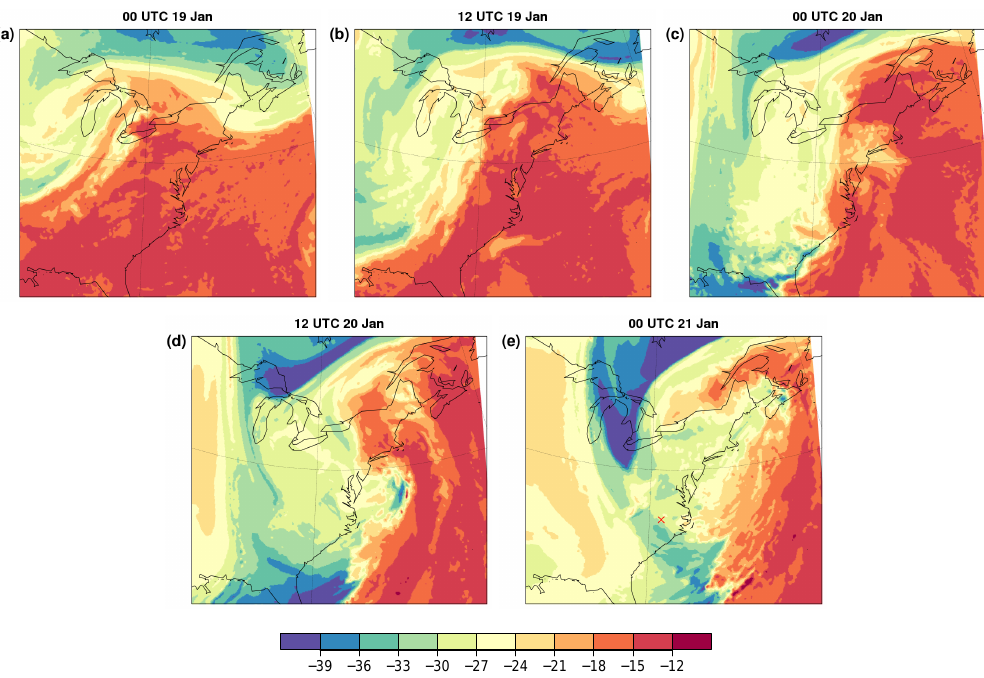
Fig. 9. δ 18 O in water vapour (in ‰) on 850hPa at (a) 00:00UTC 19 January, (b) 12:00UTC 19 January, (c) 00:00UTC 20 January, (d) 12:00UTC 20 January and (e) 00:00UTC 21 January from the COSMO iso reference simulation. The red cross in panel (e) indicates the location of the station RDU. front, a vertical cross section along the dashed green line in Fig. 3d at 12:00 UTC 19 January is shown in Fig. 10.